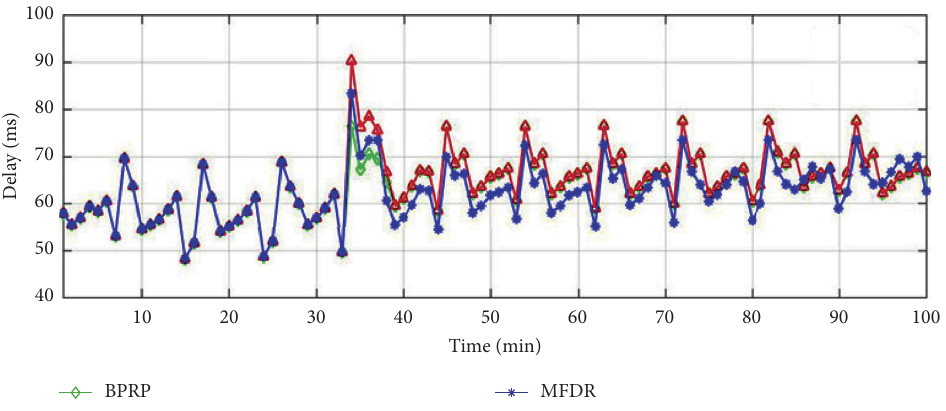
Figure 7: Relationship between time delay of recovery path and time.